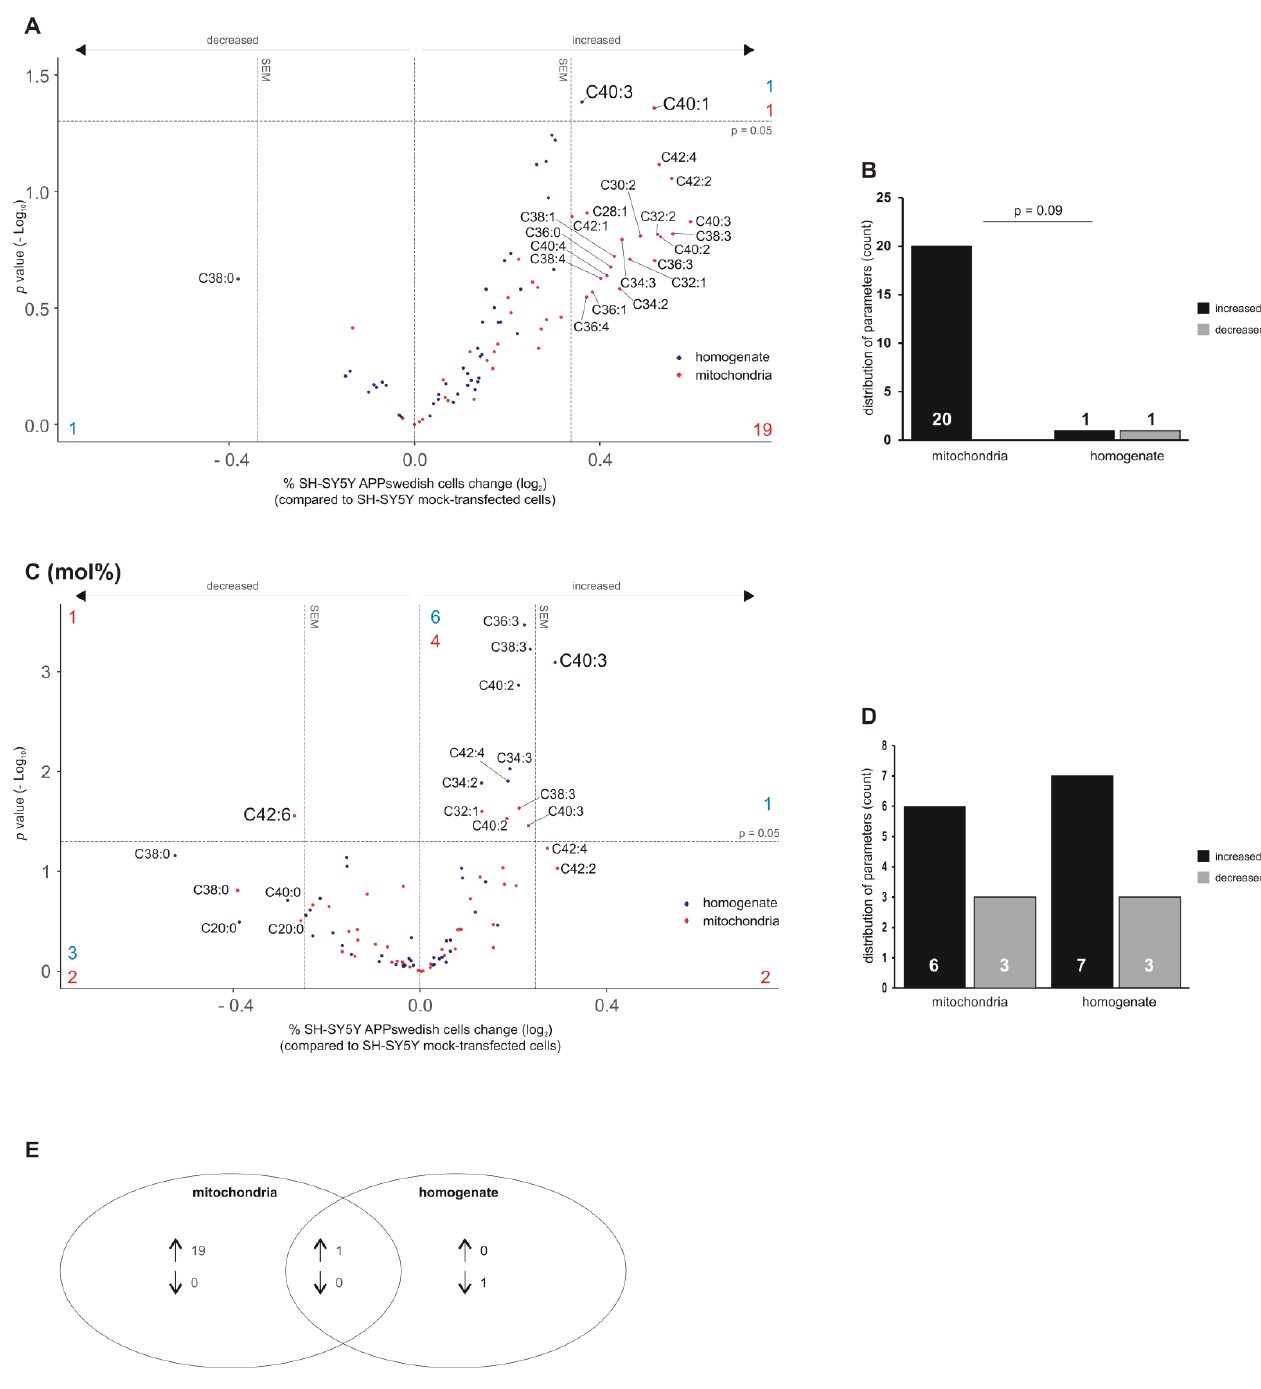
Figure 3. Changed phosphatidylcholine (PCaa) levels in homogenates and mitochondria of SH-SY5Y APPswedish cells in comparison to mock-transfected SH-SY5Y cells, respectively. ( A , B ) The fold changes of single PCaa species in homogenates and mitochondria are shown as volcano plots and the corresponding distribution analysis is shown in a bar chart on the right. ( C , D ) The effects of single PCaa species independent of PCaa lipid class effect are presented as appropriate volcano plot and bar chart. Vertical dashed lines next to 0.0 represent the average SEM and the horizontal dashed line marks p = 0.05 in volcano plots. Statistical significance was calculated using Fisher’s exact test. ( E ) Venn diagram showing the number of exclusively changed as well as overlapping PCaa species in mitochondria and homogenates in SH-SY5Y APPswedish cells compared to mock-transfected cells. Arrows indicate decreasing ( ↓ ) or increasing ( ↑ ) effects.